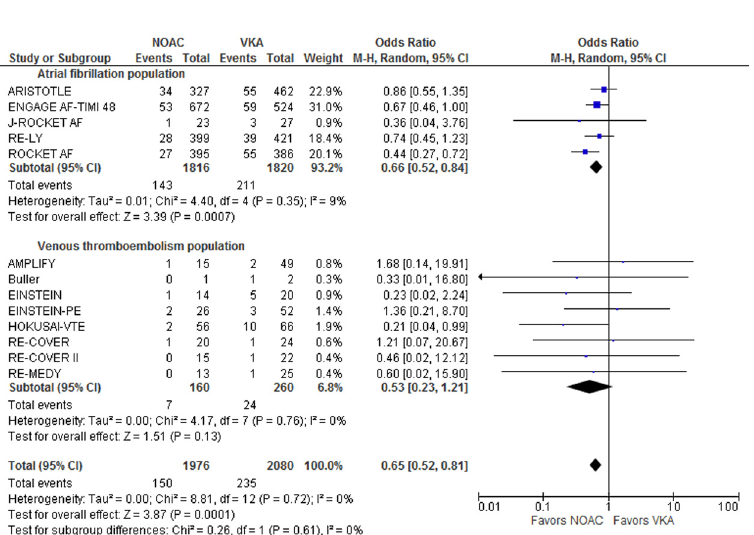
Fig 3. Relative Odds for fatal bleeding in treatment indication subgroups. Odds ratios and 95% confidence intervals are given for the relative odds that major bleeding events will lead to fatal bleeding events. Subgroups are determined by the indication for anticoagulation and fall into two categories, treatment of acute venous thromboembolism or stroke prophylaxis in atrial fibrillation.